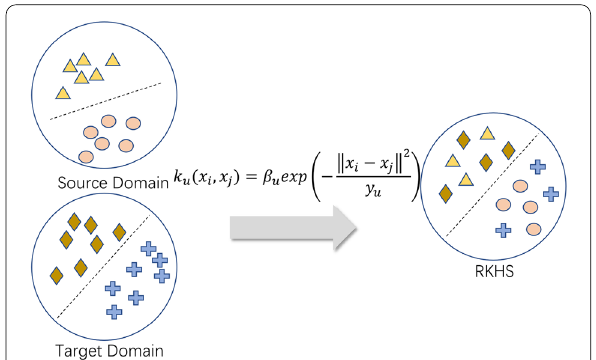
Figure 2 An example of domain adaptation using multiple Gaussian kernels (The yellow triangles and pink circles represent the positive and negative samples in the source domain, respectively. The brown prisms and blue crosses represent the positive and negative samples in the target domain,